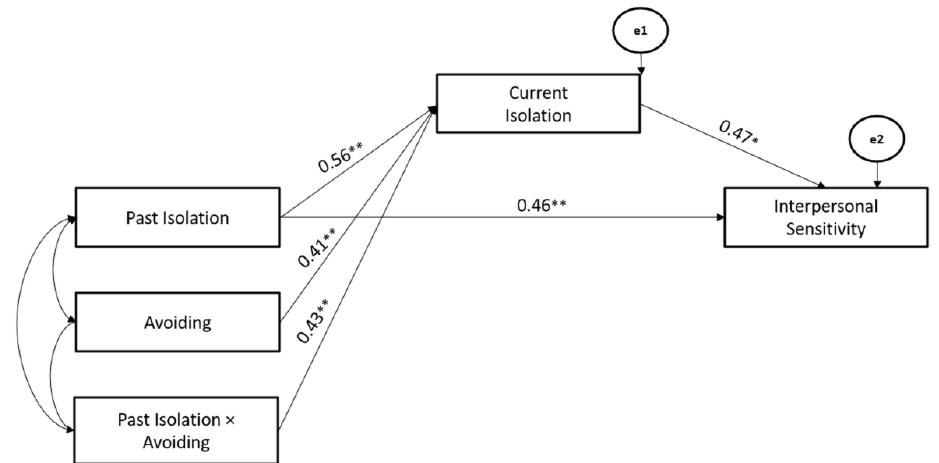
Figure 8. The Mediated-Moderated model of Past and Current Isolation stressors, Avoiding Coping Strategy, and Interpersonal Sensitivity. ** p < 0.01; * p < 0.05. Considering the significant models for Fear of Contagion, Avoiding Coping Strategy stressors (Hypothesis 2), whereas Current ‐ Fear of Contagion stressor mediated the asso ‐ ciation between Past ‐ Fear of Contagion stressor and Phobic ‐ Anxiety (Hypothesis 3). The path model showed good fit ( χ 2 = 108.43, GFI = 0.90, TLI = 0.95, CFI = 0.95, and RMSEA = 0.05) (Hypothesis 4) (Figure 9).